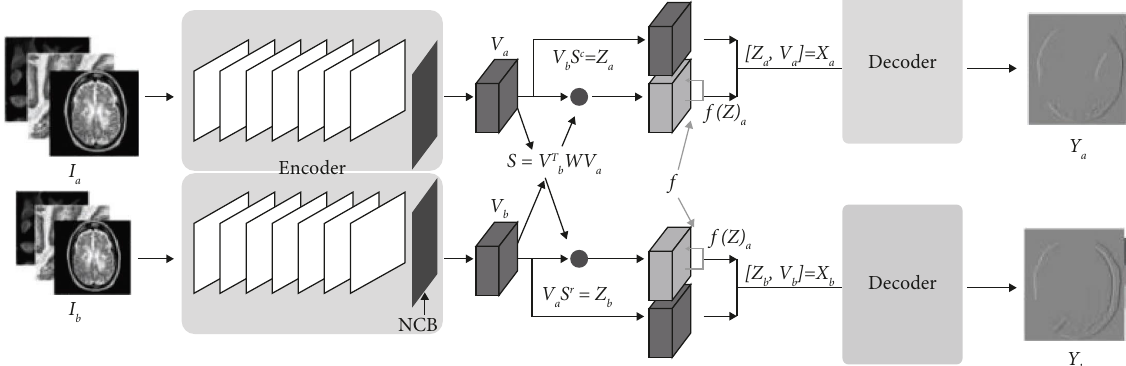
Figure 3: Multiconvolution kernel calculation process.